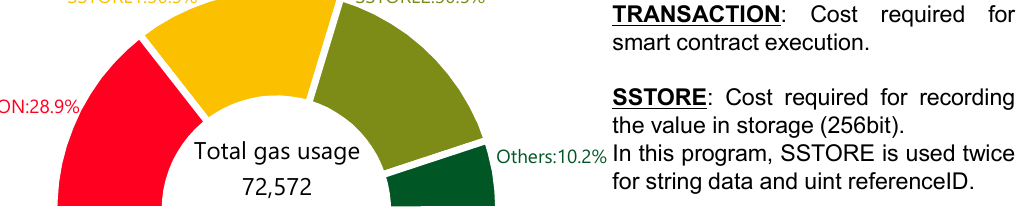
Figure 6. Breakdown of gas usage in a transaction.